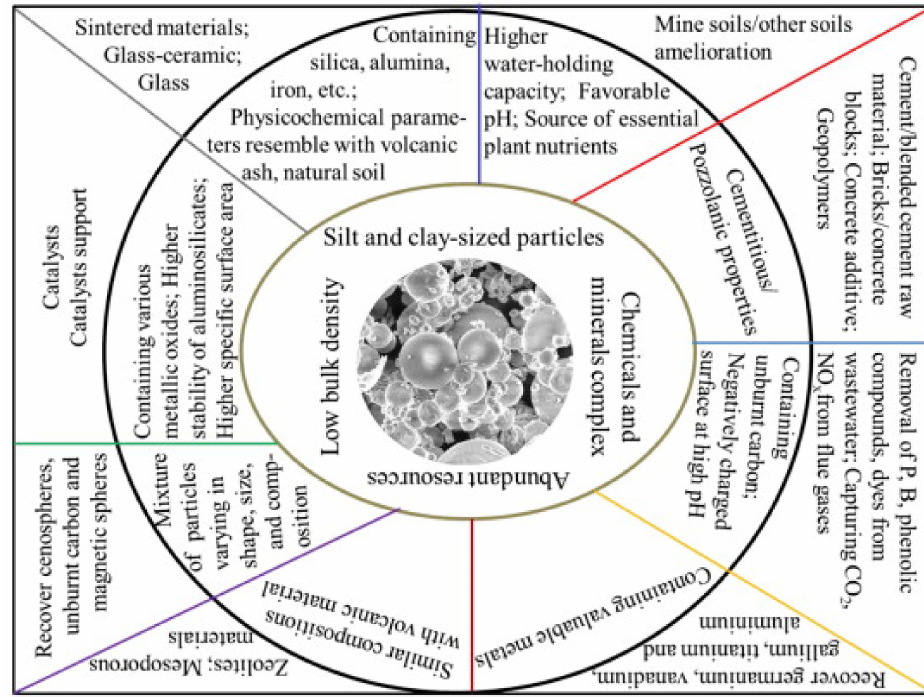
Figure 17. Typical applications of FA [92]. Reprinted with permission from Elsevier